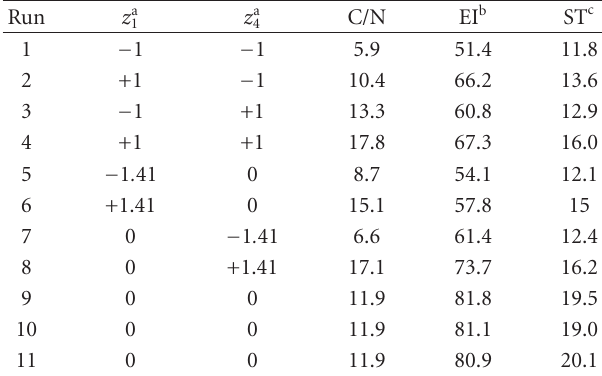
Table 6: Experimental design and results of the central composite